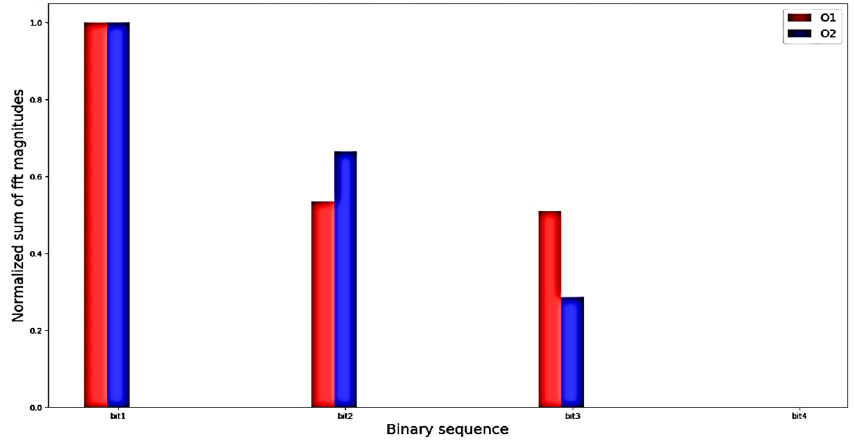
Figure 6. Bar chart showing the normalized sum of the FFT amplitudes for each EEG channel.